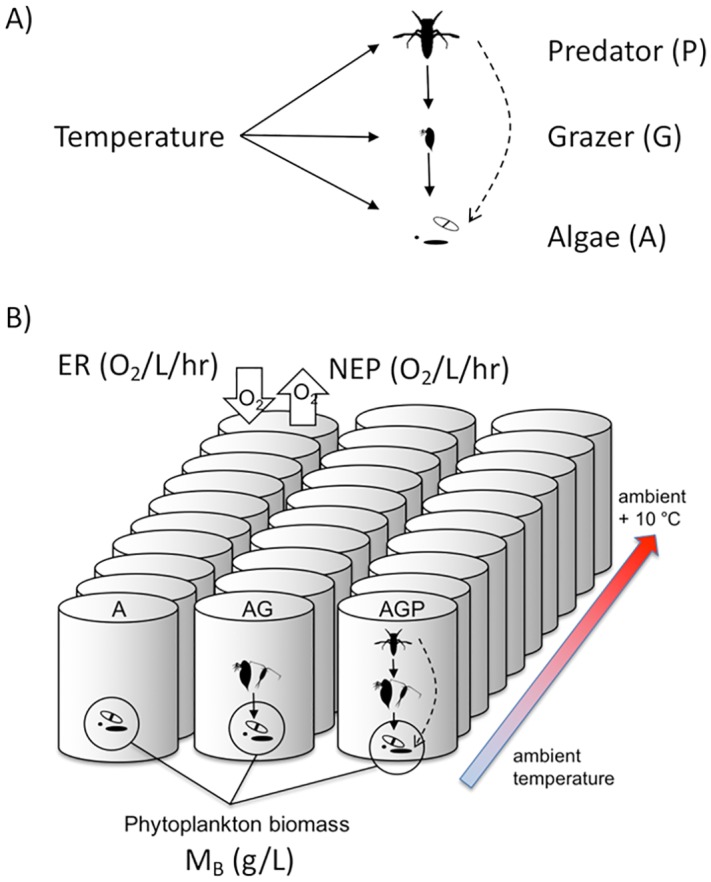
(A) Temperature and predation directly and indirectly affect population density and metabolic rates in aquatic communities. In our experimental communities, predation directly (solid lines) affects the abundance, size, and species composition of prey, and predation by notonectids on grazers leads to an indirect effect (dashed line) called a trophic cascade on algal abundance. Temperature directly affects per capita metabolic rates (solid lines) and indirectly affects algal abundance (dashed lines) by increasing grazing rates, and may have stronger effects on heterotrophic metabolic rates relative to algal metabolic rates (thicker lines represent a stronger direct effect of temperature). Other indirect effects of temperature are possible. (B) Experimental communities varied in their trophic structure. Ten communities included algae only (A), 10 comprised algae + grazers (AG), and 10 included algae + grazers + predators (AGP). We sampled net ecosystem oxygen production (NEP), ecosystem respiration (ER), and total phytoplankton biomass (MB) weekly for 8 weeks. AG, algae + grazers; AGP, algae + grazers + predators; ER, ecosystem respiration; MB, total phytoplankton biomass; NEP, net ecosystem oxygen production.